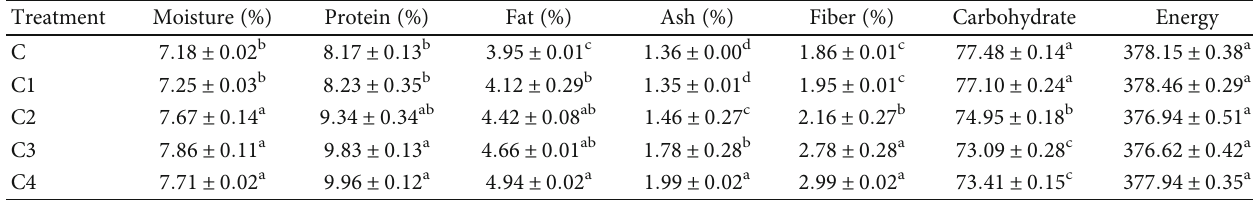
Table 2: E ff ect of blending ratio on proximate composition of wheat-amaranth bread. Treatment